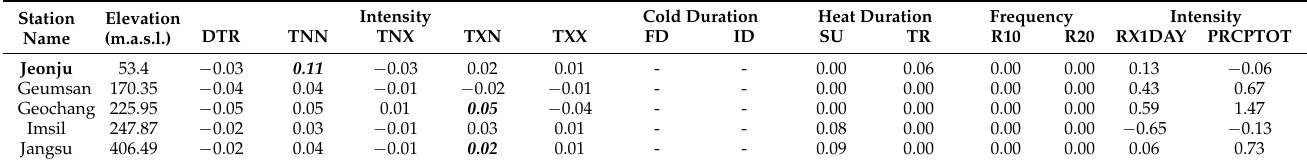
Table A15. Trend magnitudes for the month of September in the UGRB for 33 years (1988–2020).